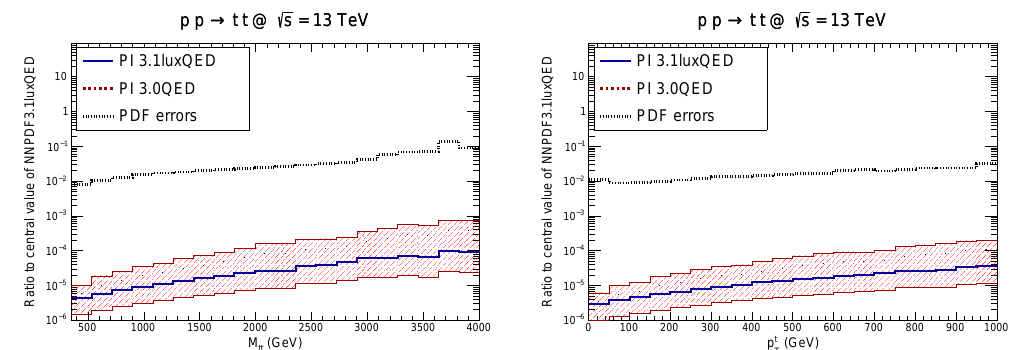
Figure 4.6: Same as Fig. 4.3 for the invariant mass distribution of top quark pairs m and the transverse momentum of top quarks p t 13